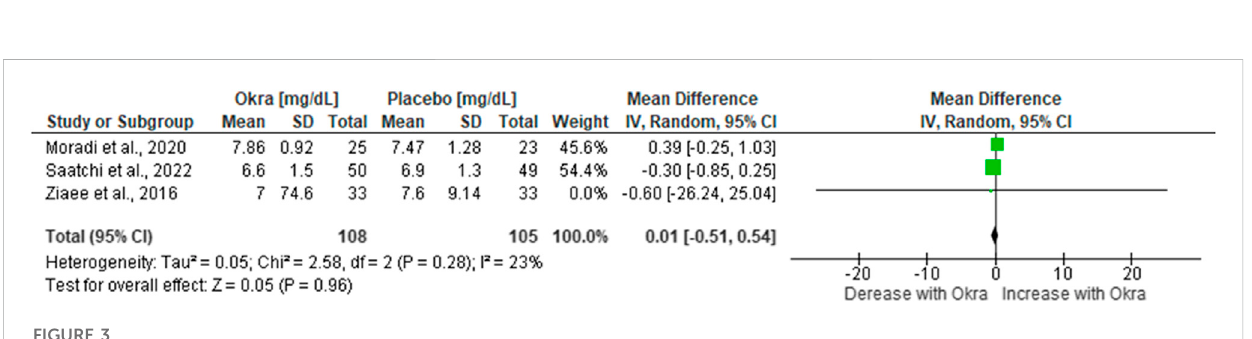
FIGURE 3 Effects of okra on glycated haemoglobin (HbA1c) in type 2 diabetes patients.